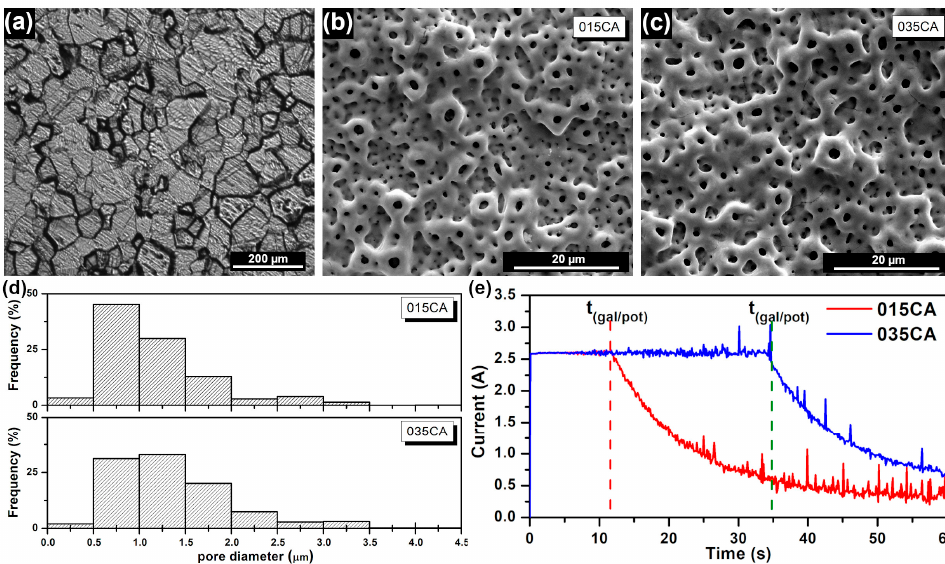
Figure 1. ( a ) Optical microscope image of Ti after etching; ( b , c ) SE SEM images of Ti after MAO treatments; ( d ) pore size distribution for MAO groups; ( e ) evolution of current during MAO treatments.